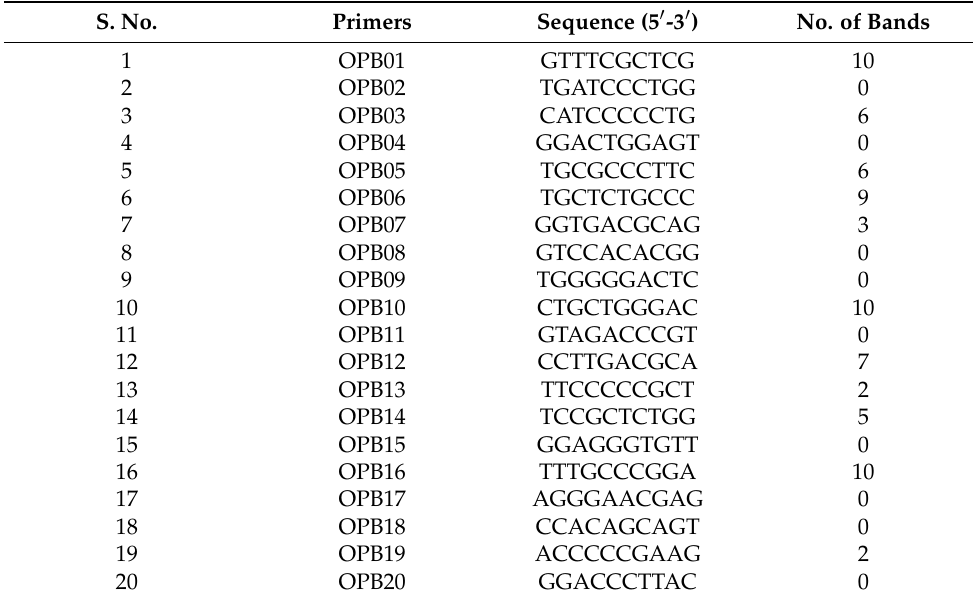
Table 7. Randomly amplified polymorphic DNA primers (Kit B) used to assessed in vitro-propagated L. speciosa